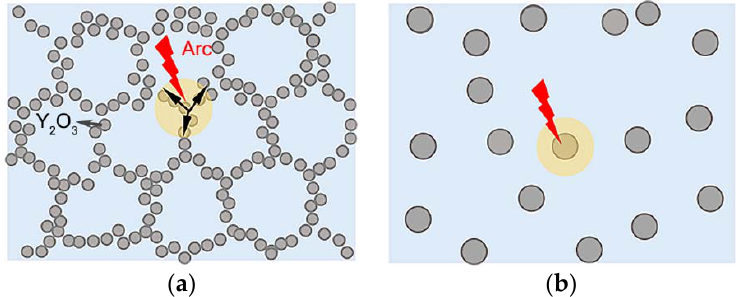
Figure 9. Arc movement characteristics: ( a ) moving along the Y 2 O 3 network, ( b ) staying around the Y 2 O 3 particles.